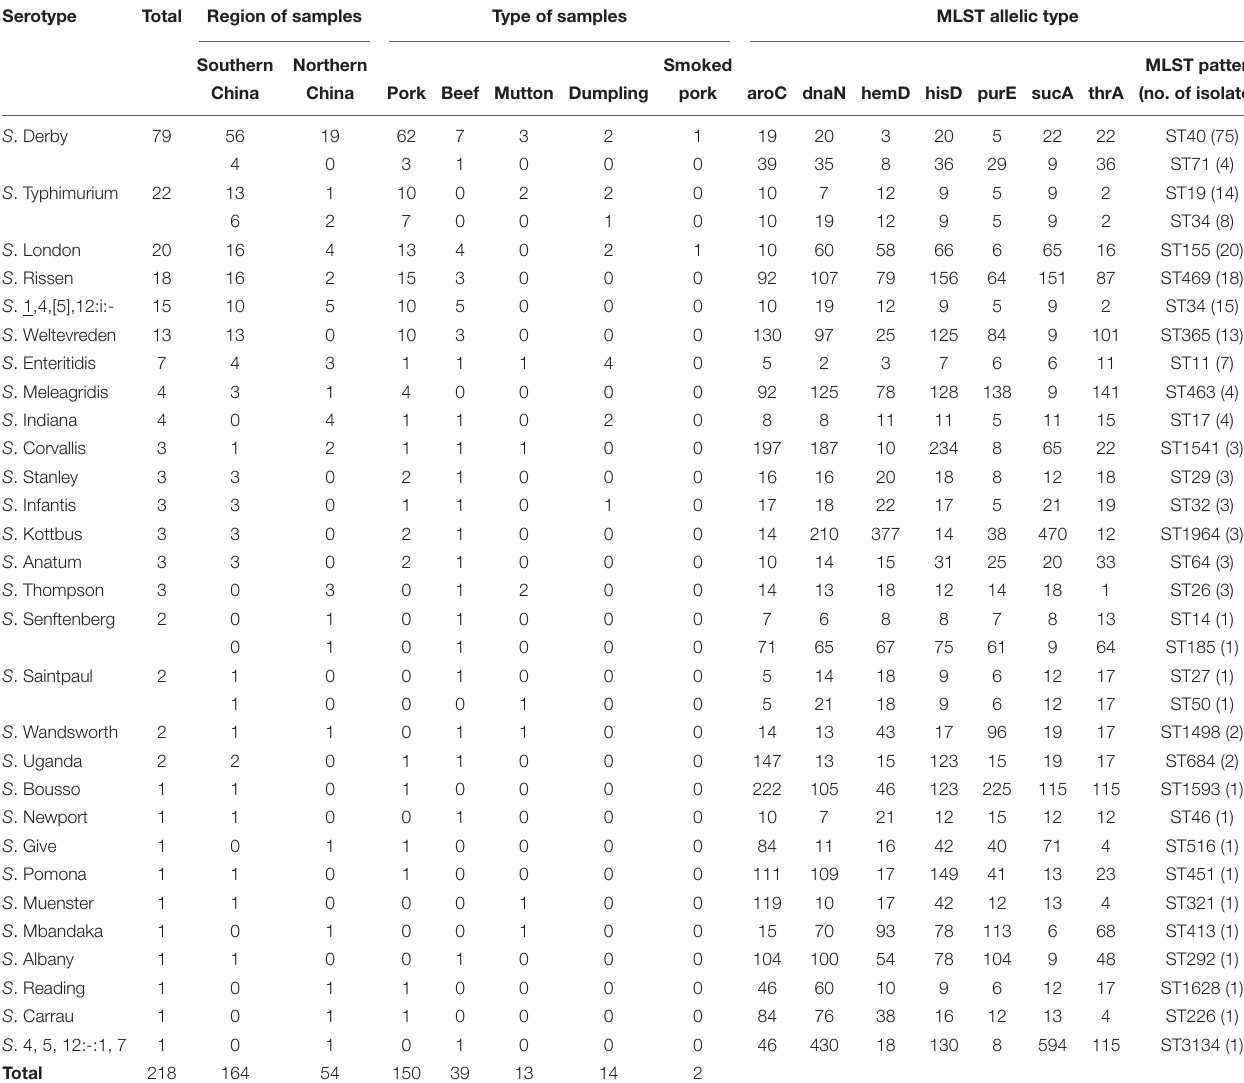
TABLE 2 | Distribution of Salmonella serovars and multilocus sequence typing patterns of isolates from retail meat and meat products from China. Serotype Total Region of